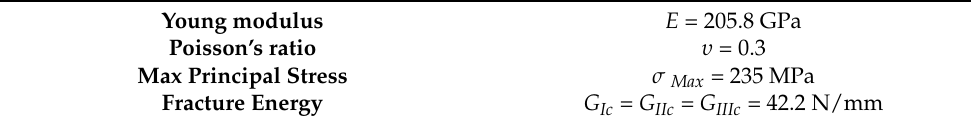
Table 2. Material properties of stiffened plate